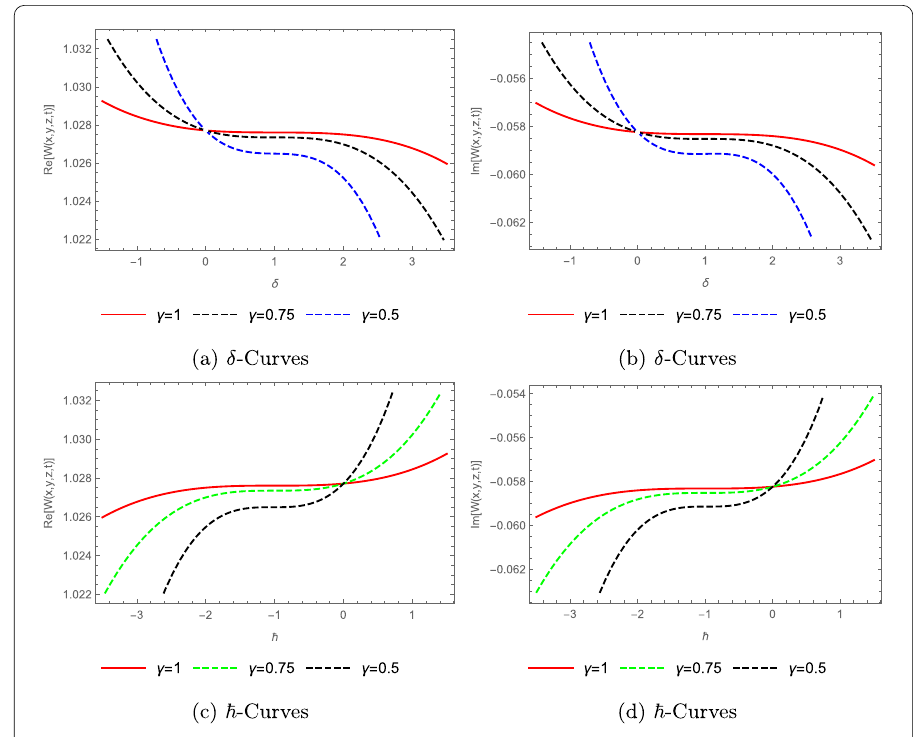
Figure 8 The curves plots of the real and imaginary parts of δ -HPTM and q-HATM solutions for Example 2